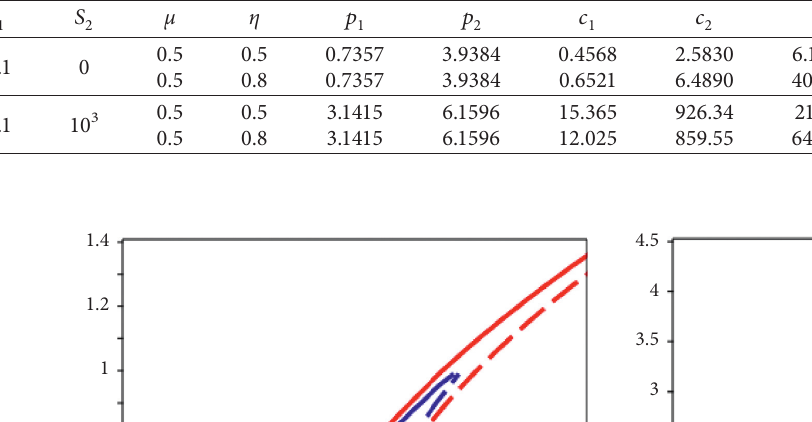
� 10and K � 100). 1 2